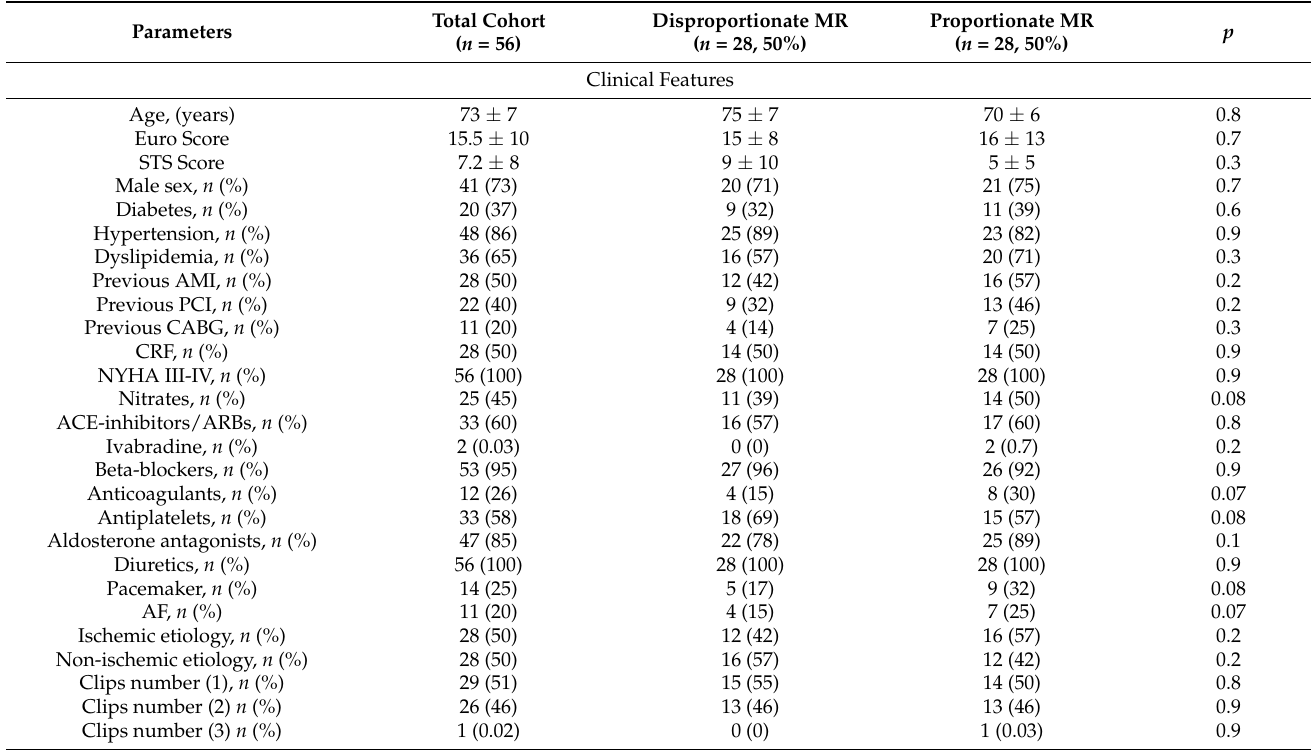
Table 1. Clinical and echocardiographic variables in the overall population and in Proportionate vs. Disproportionate MR patients at